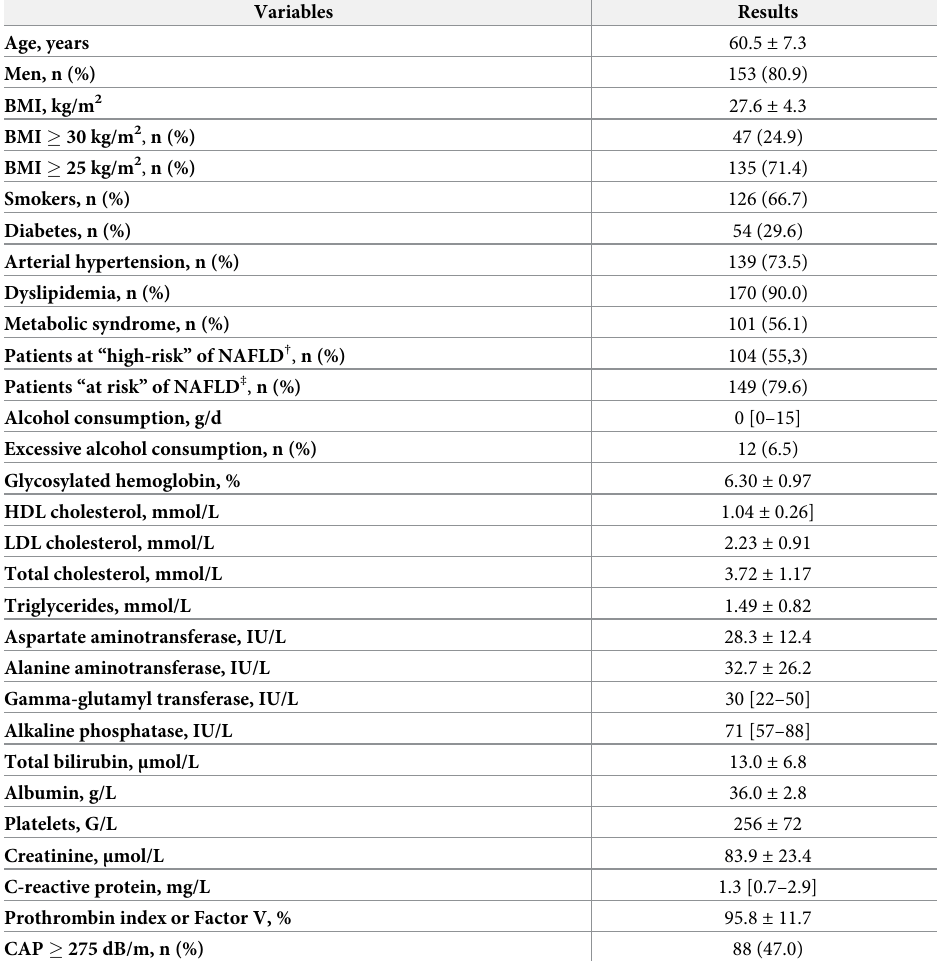
Table 1. Biological and demographic characteristics of